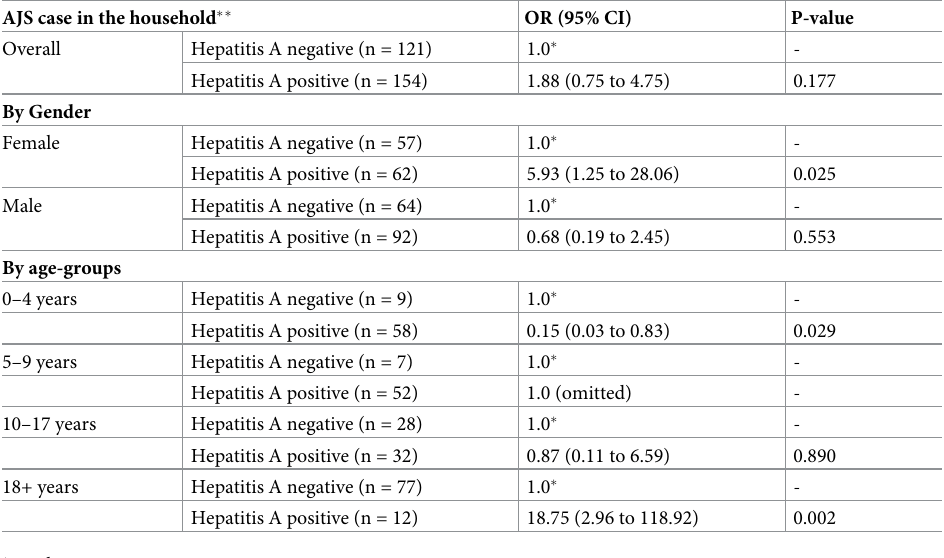
Table 5. Odds ratio for the association between household transmission and hepatitis A seropositivity by gender. AJS case in the household